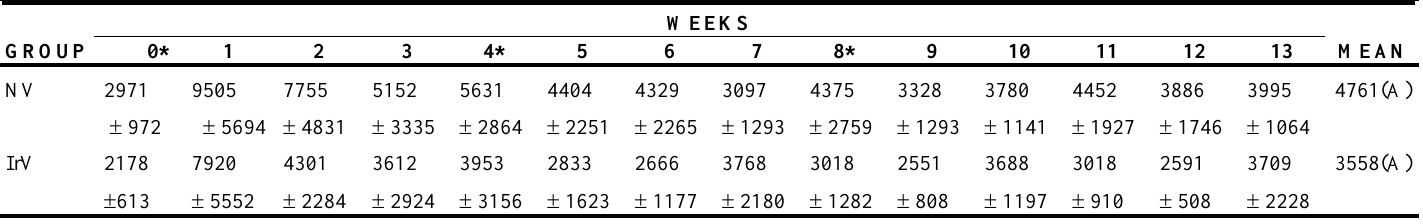
Table 2. Means and standard deviation of neutrophil count (cells/ µ L) in sheep (n=12) inoculated at days zero, 30, and 60 with natural (NV) and -irradiated (IrV) crotalic Cobalt 60